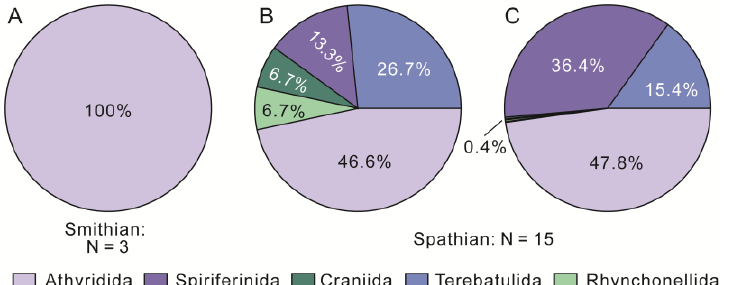
Figure 13. Composition of the Datuguan brachiopod fauna. ( A , B ) are based on species amount data, and ( C ) is based on specimen data. N, number of species.